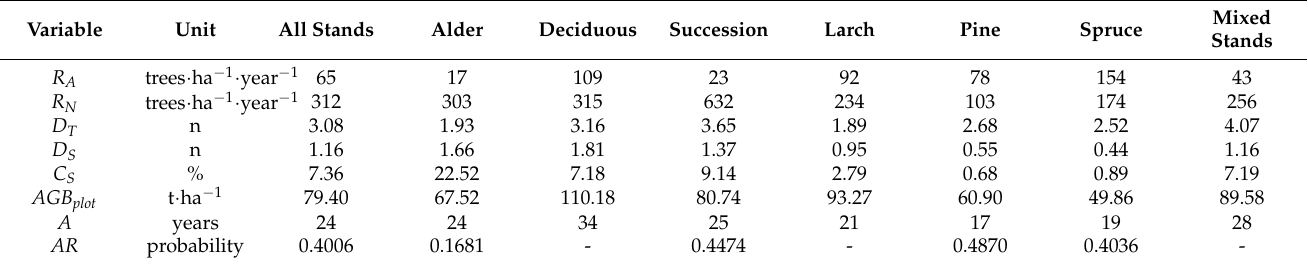
Table A5. Mean value of other stand characteristics for inventory plot data and attractiveness for recreation.